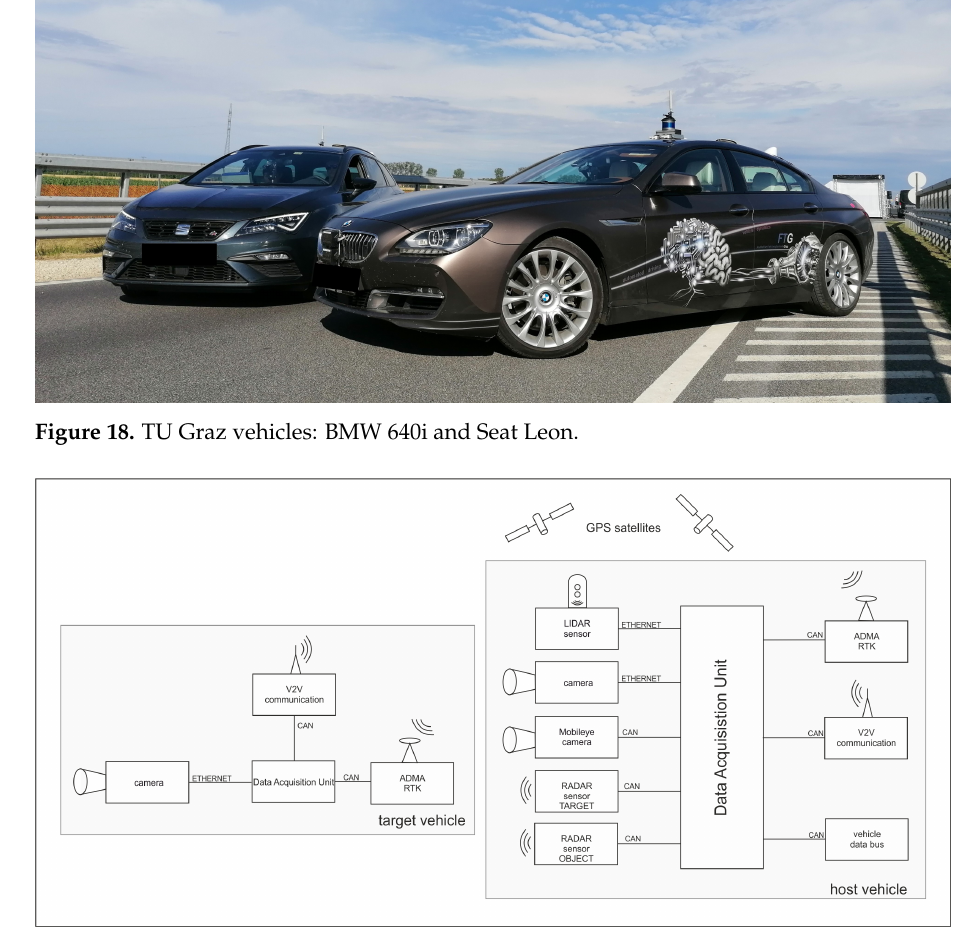
Figure 19. TU Graz measurement